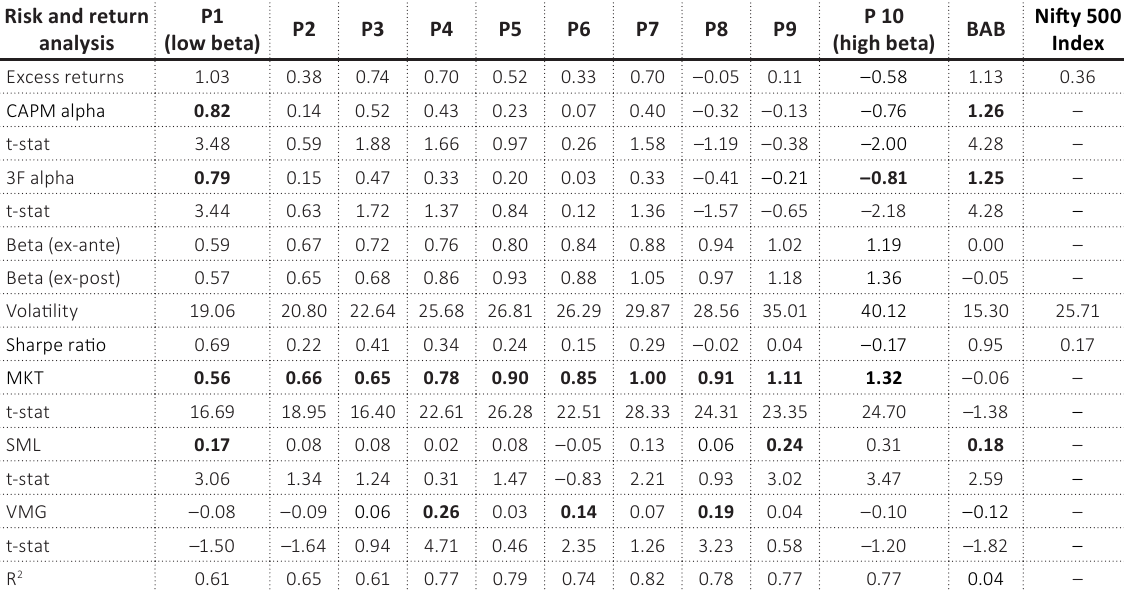
Note: Bold indicates 5% statistical